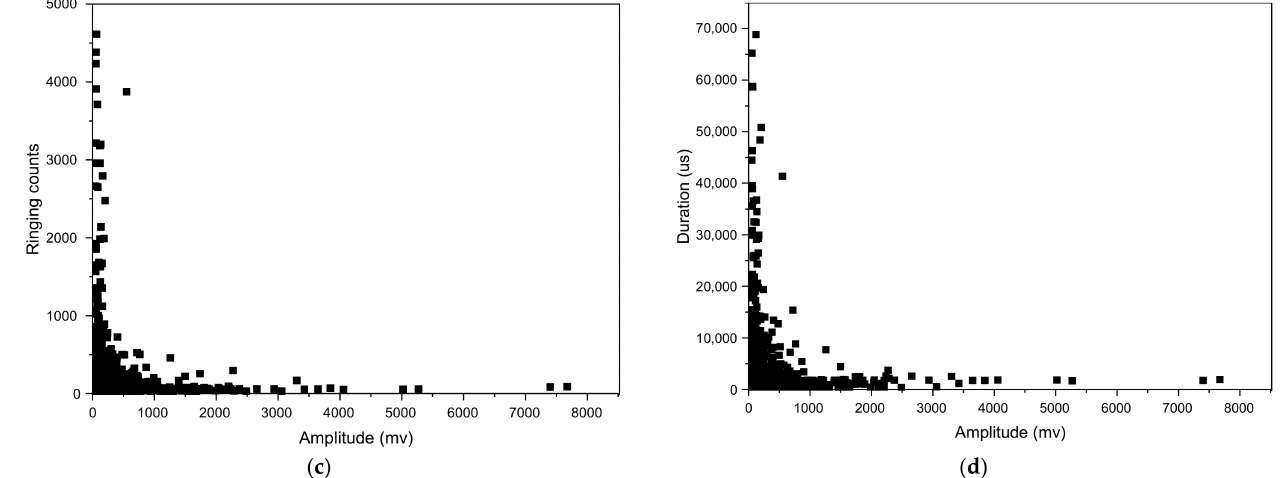
Figure 9. The acoustic emission signal correlations of the A-7-80% sample. ( a ) The total energy in terms of amplitude. ( b ) The frequency of the peak in terms of amplitude. ( c ) The ringing counts in terms of amplitude. ( d ) The duration in terms of amplitude.